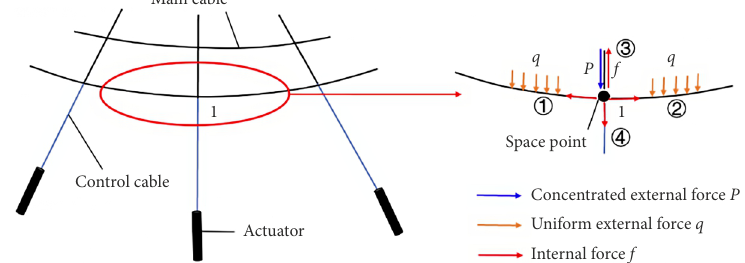
Figure 4. Description of a cable-net space point